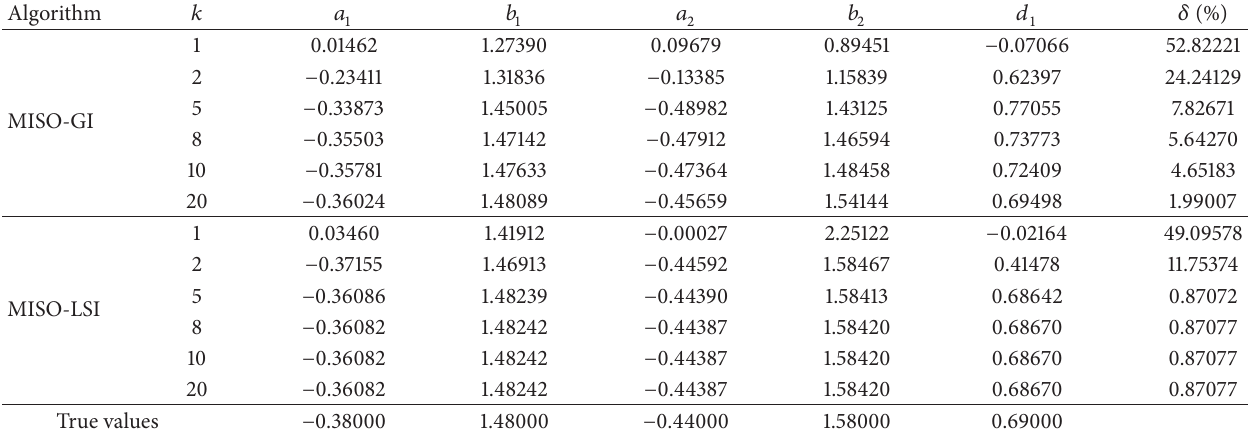
Table 1: The MISO-GI and MISO-LSI estimates and errors ( 𝜎 2 = 0.50 2 ).